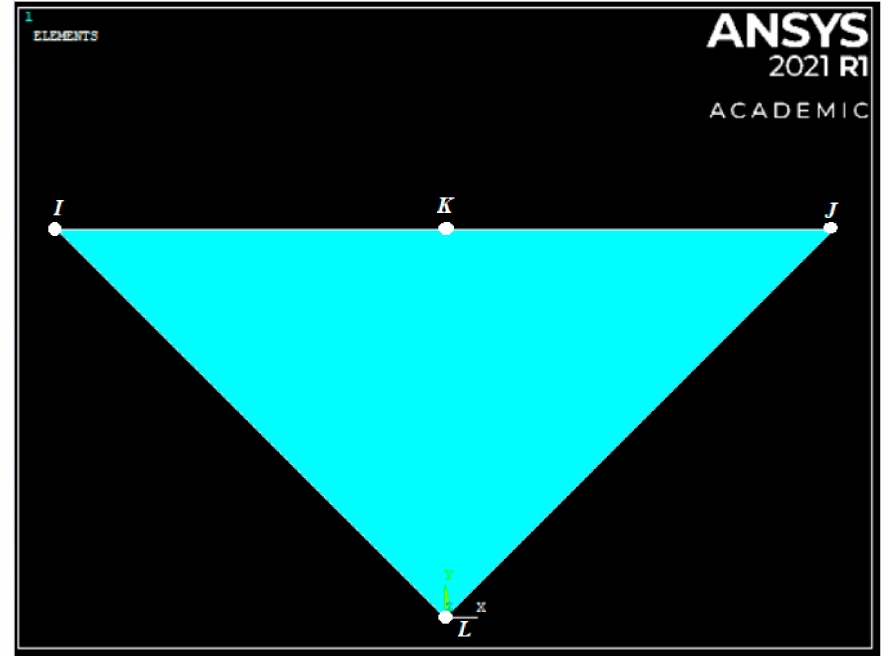
Figure 15. The geometry of the hydrostatic HSFLD241 element with the surface nodes ‘I’ and ‘J’, as well as the pressure node ‘L’ [13].